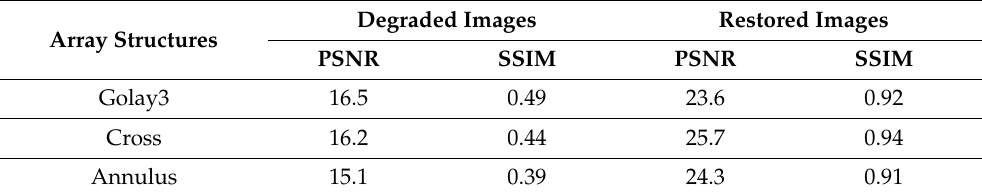
Table 2. The image quality of the corresponding degraded images and restored images. Array Structures